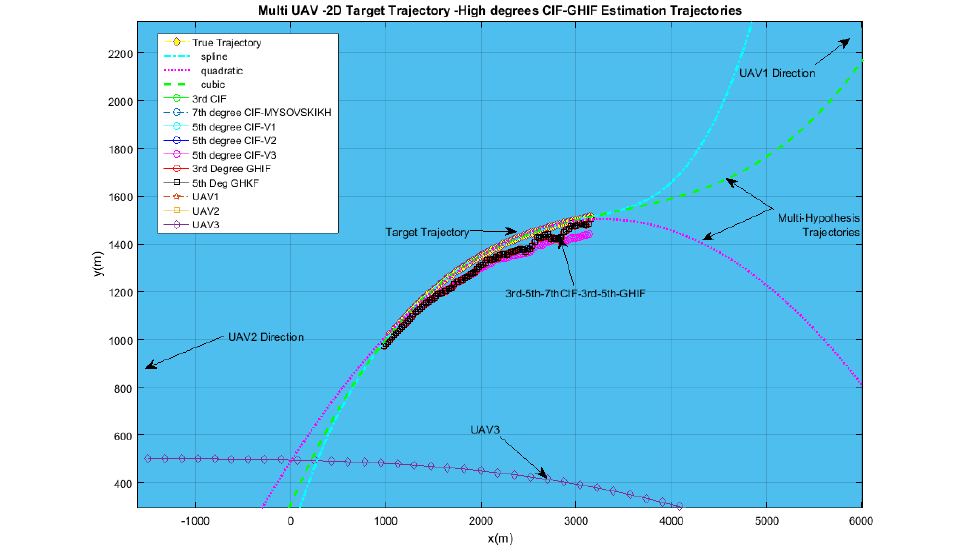
Figure 8. Zoom on range rate Doppler-based trajectory: Results of 7 th -degree CIF, 5 th -degree CIF, 5 th -degree GHIF, 3 rd -degree GHIF compared to the true trajectory in green color. The lower error bound was achieved by 7 th -degree CIF and 5 th -degree